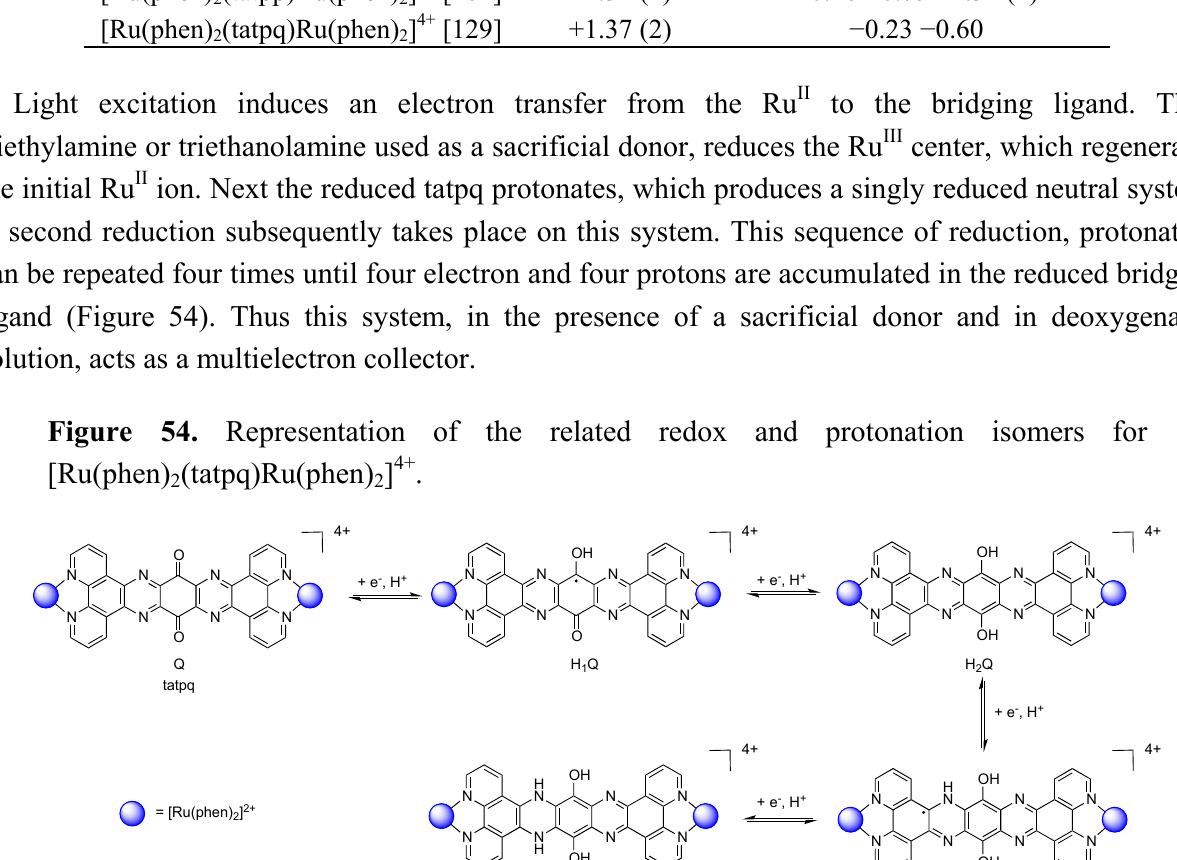
14. Redox potentials vs. SCE for [Ru(phen) [Ru(phen) (tatpq)Ru(phen) ] 4+ measured in acetonitrile. In parenthesis is the number of 2 2 Complex Oxidation Reduction +1.32 (2)